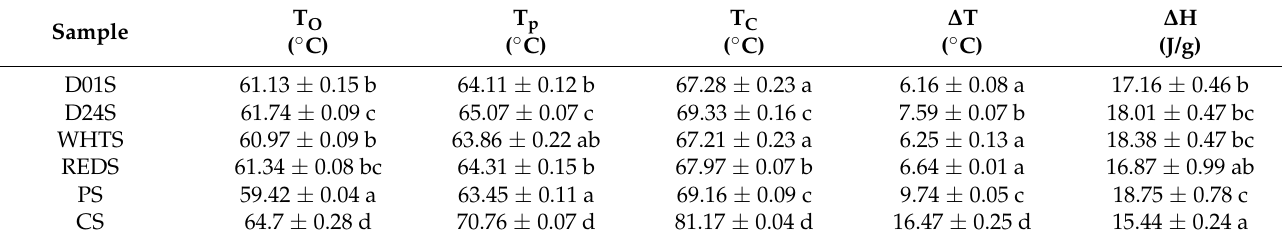
Table 5. Thermal properties of anchote, potato, and cassava